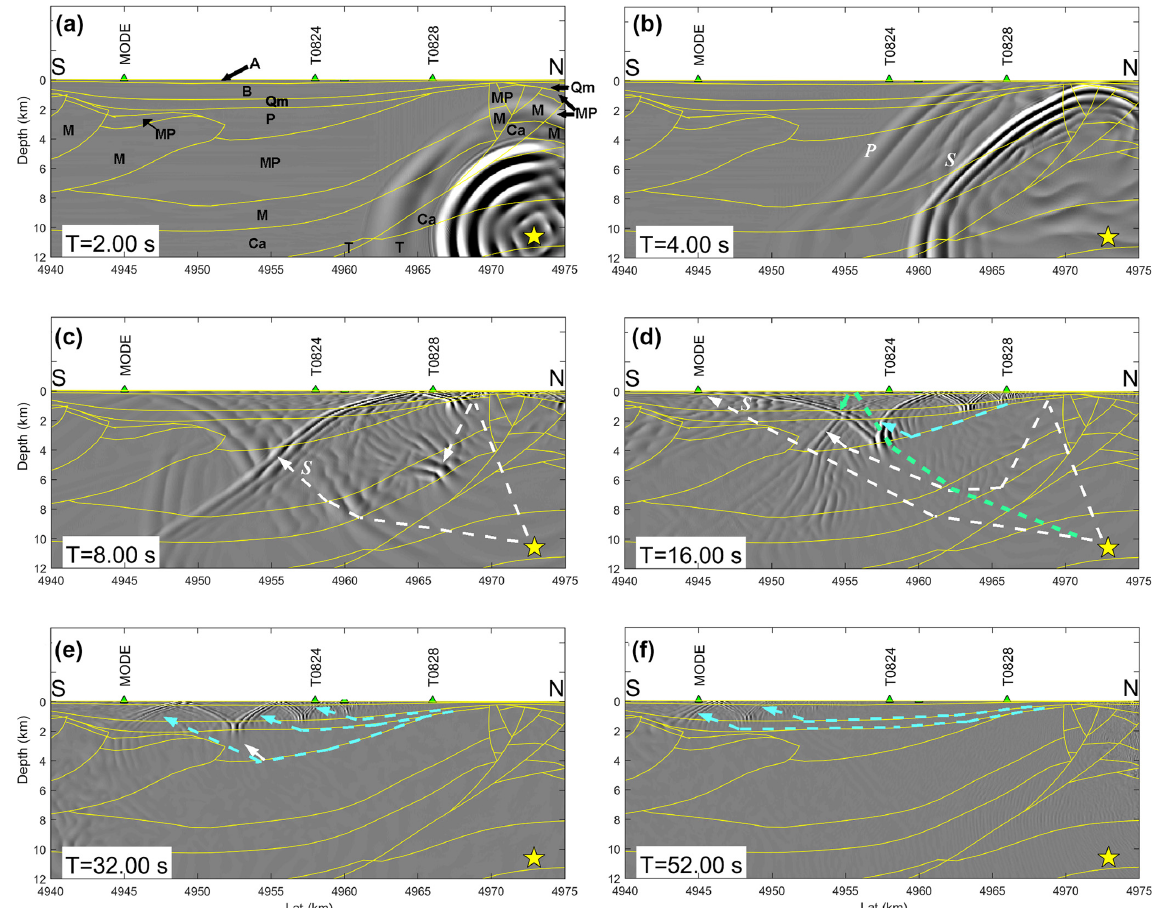
Figure 11. Numerically evaluated seismic wavefield for the June 2012 M W 4.1 event across the south–north vertical section represented in Fig. 1 (red dashed line). Green triangles: projection of the nearby station locations. Yellow star: hypocenter. Yellow lines: interfaces among structural units. (a) Snapshot taken after 2s of propagation. Black letters: structural unit identifiers – see Table 1. (b) Snapshot taken after 4s of propagation. P and S : wavefronts of the compressional and shear body waves, respectively. (c) Snapshot taken after 8s of propagation. (d) Snapshot taken after 16s of propagation. The S waves dominate the scene. The dashed turquoise line denotes the ray path of the waveform reflected from the surface; the dashed cyan line denotes the total reflection on the interface between the MP and P units. (e, f) Snapshots taken after 32 and 52s of propagation, respectively. Surface wave overtones are clearly visible in the soft soil layers in the upper part of the structure. The dashed cyan lines evidence the wave trains as well as the corresponding interfaces that originate the total reflection. The full sequence of snapshots is available as a movie file on the Open Science Framework (Klin,